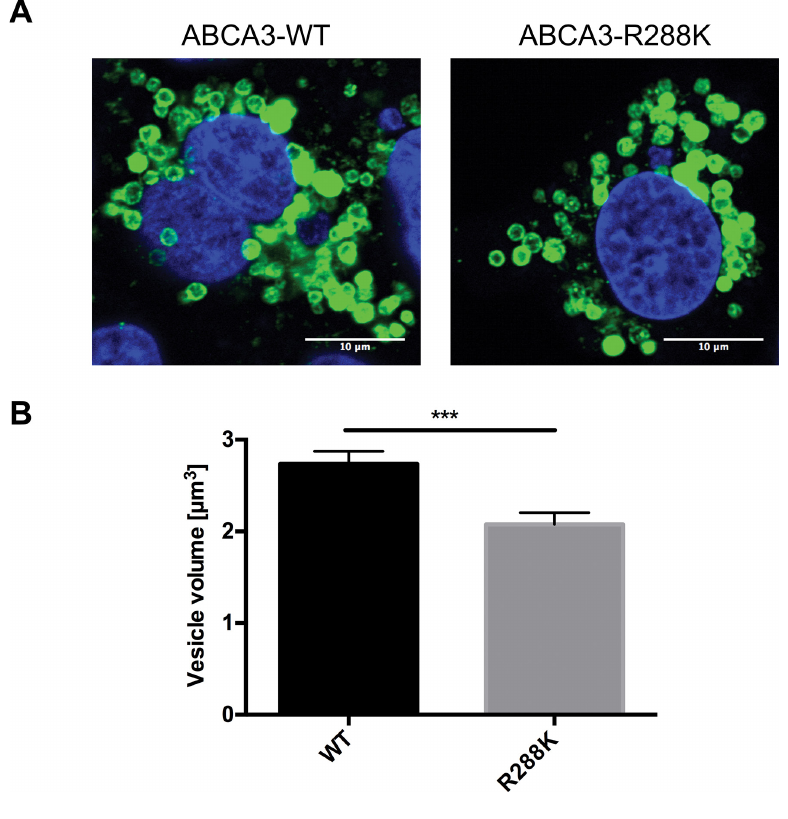
Figure 4. Determination of vesicle volumes in A549 cells with ABCA3-WT or ABCA3-R288K protein. (A) Immunofluorescence staining of HA-tagged ABCA3 vesicles imaged with a confocal microscope. Shown is either ABCA3-WT (left) or ABCA3-R288K containing vesicles (right). (B) Volumes of ABCA3 containing vesicles harboring either ABCA3-WT or ABCA3-R288K were calculated on the basis of vesicle diameters determined with ImageJ software tool. *** P <